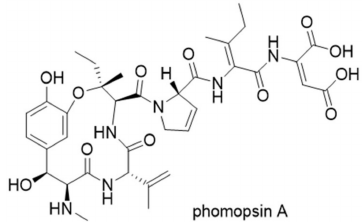
Figure 11. Structure of phomopsin